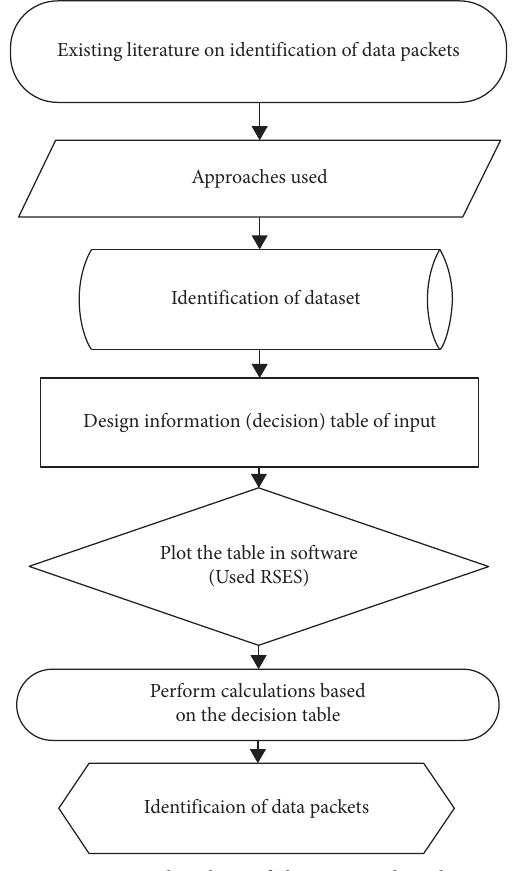
Figure 1: Flowchart of the proposed